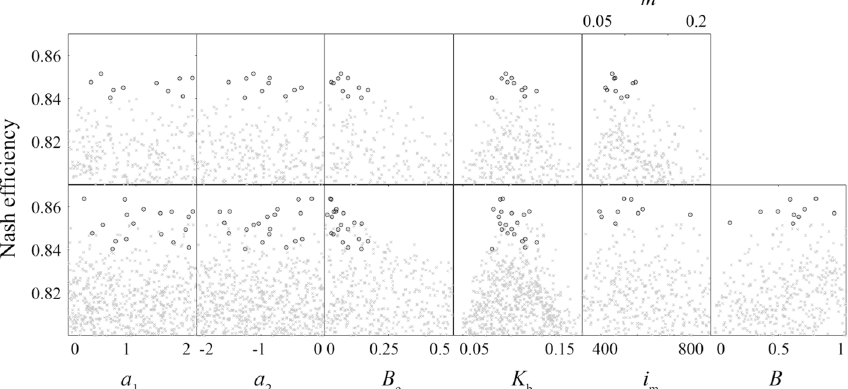
Fig. 8. Nash efficiencies as function of model parameter (gray dots) and 1% best simulations (black circles) for the Willlamette River basin: snow parameters a 1 ( − ) and a 2 ( − ), evaporation parameter B e ( − ), baseflow parameter K b (day − 1 ), TRG scaling parameter m (m), VIC maximum storage capacity im (mm), and VIC shape parameter B ( − ). The top line gives the efficiencies for the model with the TRG algorithm and the bottom line the efficiencies for the VIC-algorithm